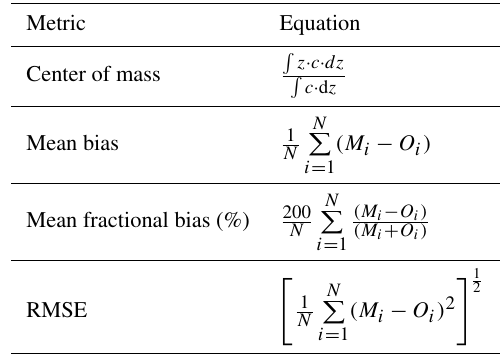
Table 2. Common metrics equations. The model data are defined as M and the lidar observational data as O . The z and c symbols correspond to the height and the concentration,